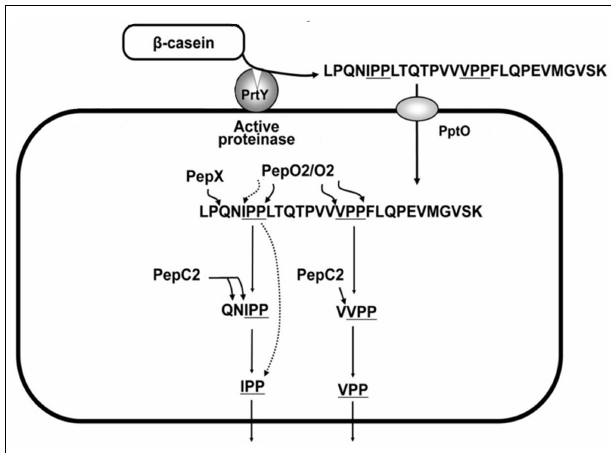
FIGURE 2 | Postulated proteolytic system forVal-Pro-Pro and Ile-Pro-Pro processing in L. helveticus . Modified fromWakai etal. (2012). The proteolytic action of the cell-wall proteinase (PrtY) on β -casein produces a casein peptide of 28 amino acids includingVPP and IPP sequences.The peptide is incorporated into the cell by the oligopeptide transporter (PptO), and processed intracellularly toVPP and IPP by endopeptidases at the C- and N-terminal sequence. A key enzyme recently identified in L. helveticus CM4 strain and characterized by a homology to an endopeptidase (PepO2) can catalyzed C-terminal processing ofVPPFL and IPPLT toVPP. As for the N-terminal end the release ofVPP and IPP may be catalyzed by specific aminopeptidases, such as pepC2 and X-prolyl dipeptidyl aminopeptidase (PepX), since PepX is able to release the di-peptide with a sequence